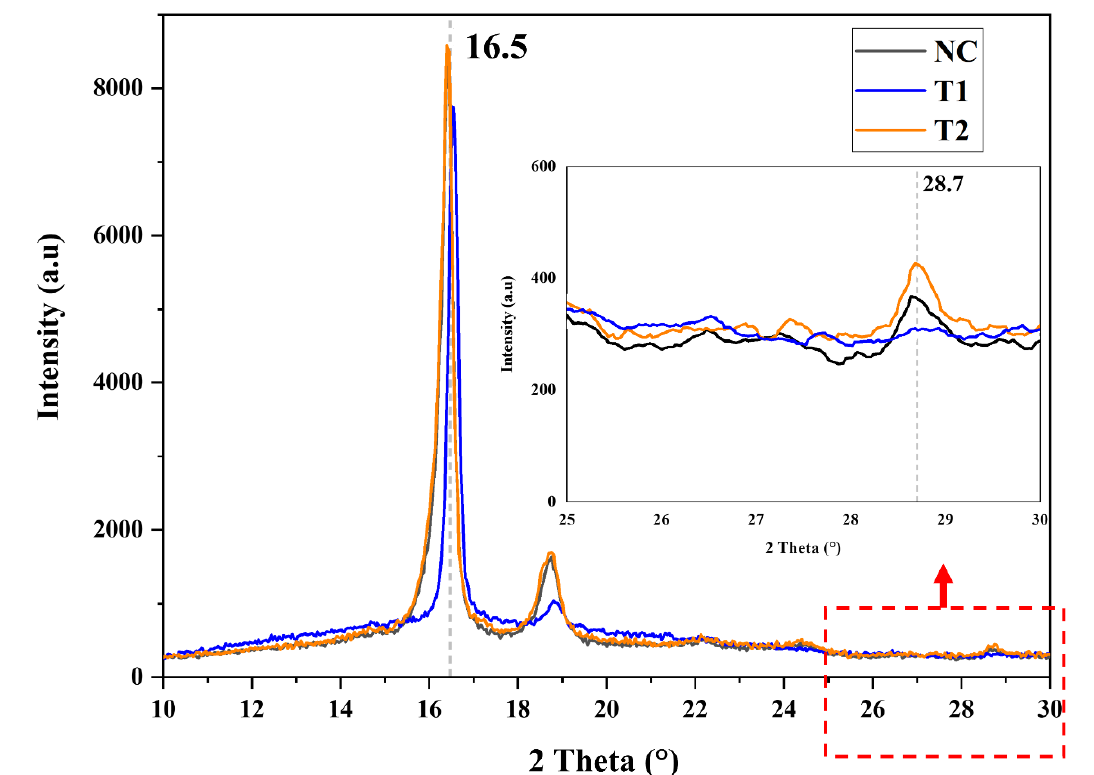
Figure 8. XRD pattern of nanocomposite without and with compatibilizers at a ratio of 1:1 compatibilizer to nanofiller. Note: NC represents the sample with no compatibilizer, T1 represents the sample with compatibilizer via two-step method. Meanwhile, T2 represents the nanocomposite sample with MAH compatibilizer and DCP via one-pot method.